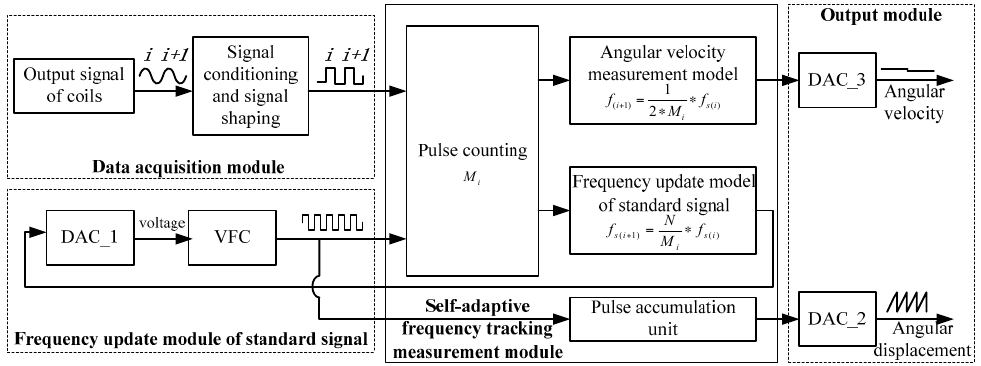
Figure 3. Schematic diagram of the general design scheme of the sensor.